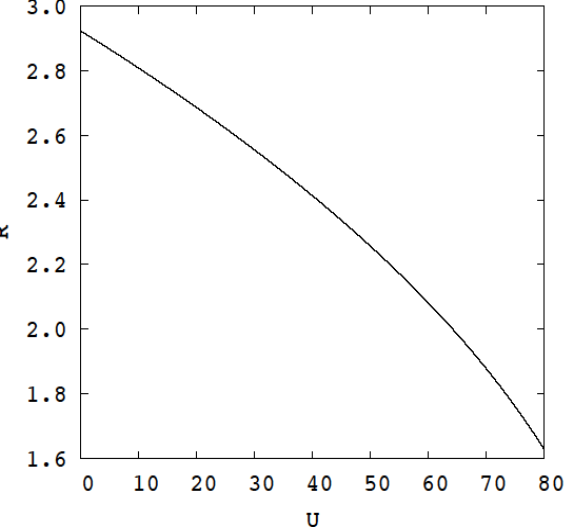
Figure 3. Rate of change of the distribution radius for constants k = 0.35; l = 0.5 and initial data of initial charge and radius C = 0:292 and R (0) = 2:923, respectively. varies from 0.6 to 1.0, for k = 0.35; l = 0.5